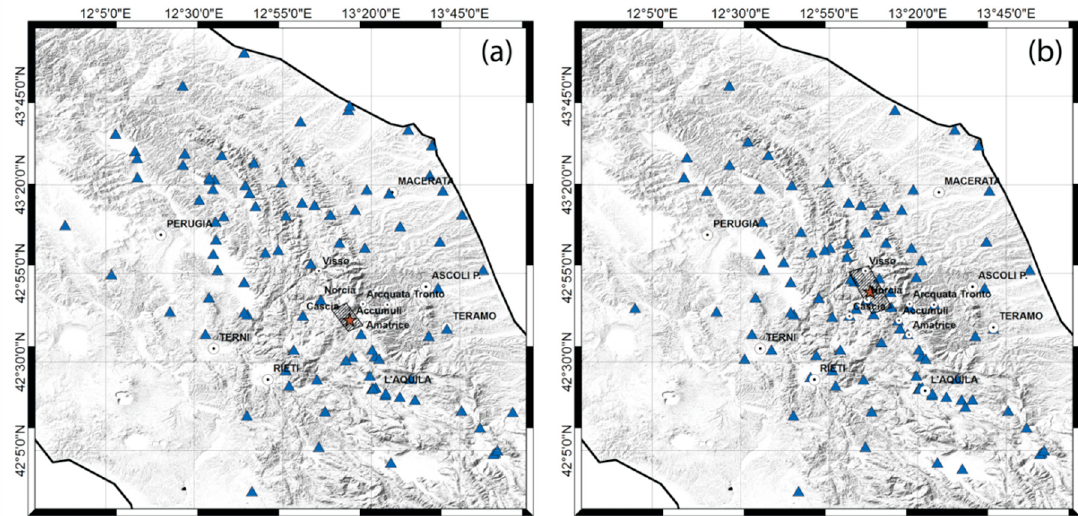
Figure 1. Configurations of the accelerometric seismic network during the two main events of the 2016–2017 Central Italy seismic sequence: on 24 August 2016, the M W 6.0 Amatrice earthquake ( a ), and on 30 October 2016, the M W 6.5 Norcia earthquake ( b ). Red stars are the epicenters (http://cnt.rm.ingv.it/) and dashed rectangles indicate the faults projected on the surface (http://shakemap.rm.ingv.it/). The horizontal acceleration time histories, with two orthogonal components for each site, were processed for calculating CAV STD with a threshold acceleration of 10 cm/s 2 , AI, PGA, and